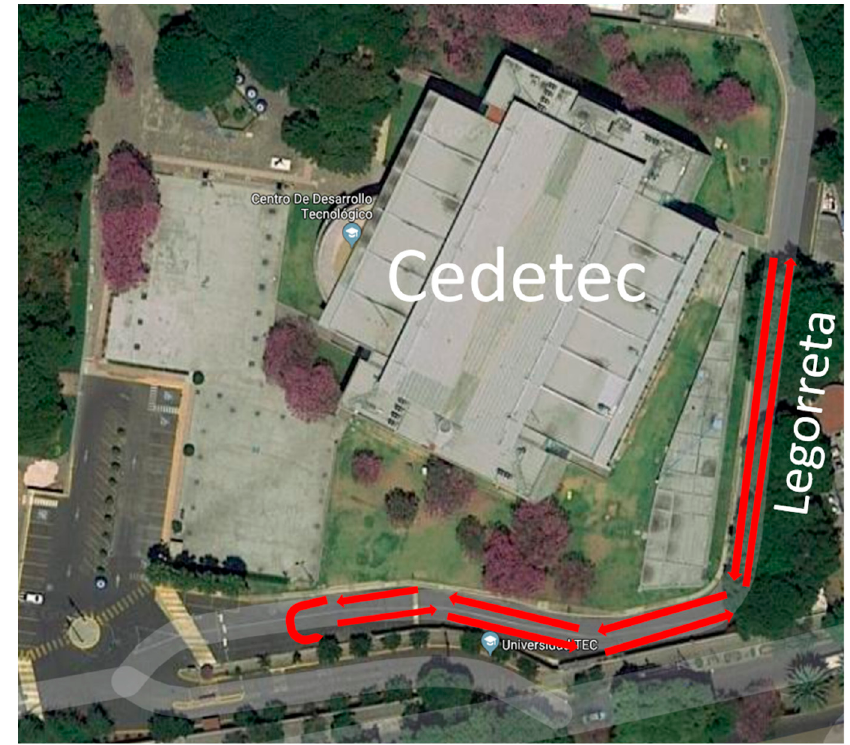
Figure 6. Test track satellite view.